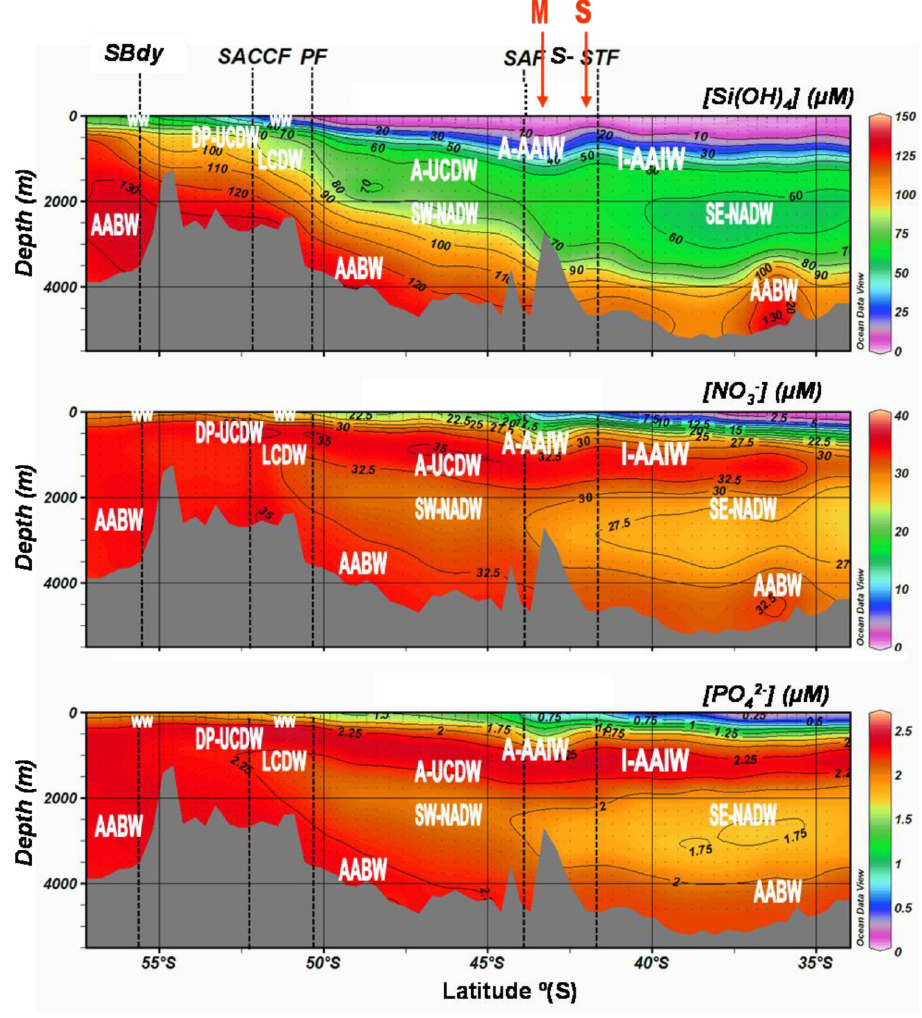
Fig. 2. Contour plots of silicate (Si(OH) − ; µM), nitrate (NO − ; µM), and phosphate (PO 2 − ; µM) concentrations versus depth (m) and latitude 4 3 4 along the MD166 BONUS-GoodHope section. The colour mapping extrapolation is based on the sampling resolution along the section of ∼ 2600km that was achieved with 79 stations separated by ∼ 15 to 56km, with a total of 22 sampling depths per station. Figure prepared using Ocean Data View (Schlitzer,